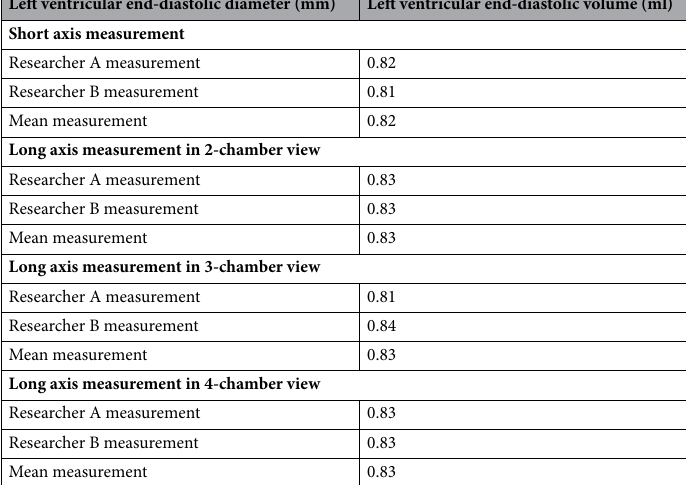
Left ventricular end-diastolic diameter